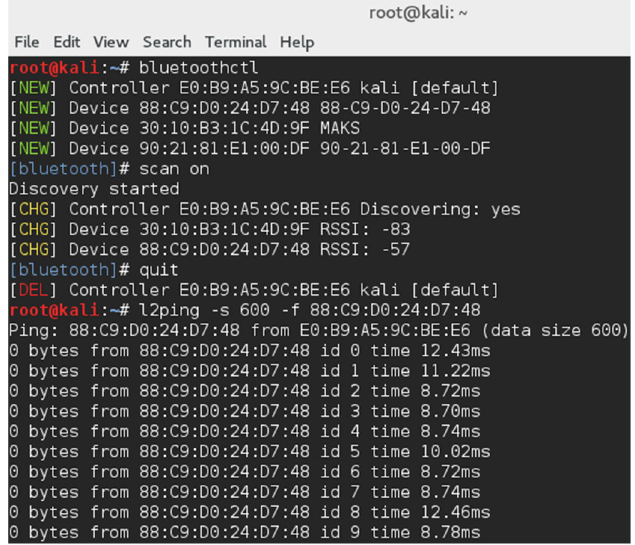
Figure 2. Tracing of vector of ERE attack on the Nexus